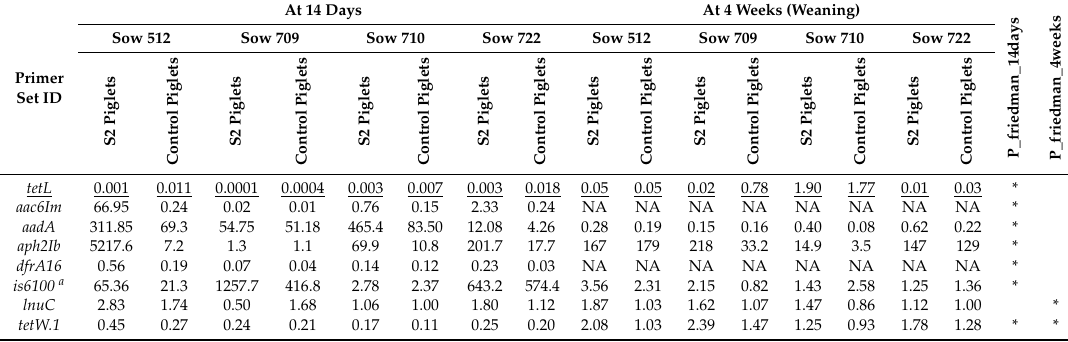
Table 2. Impact of the suspension from donor sow 206 (S2) on the abundance of ARGs and related genes in the piglets at 14 days and at 4 weeks (median values). The ARG abundances are normalized by the abundance of the 16S rRNA gene. The numbers are not between 0 and 1 because the ARGs were pre-amplified, whereas the 16S rRNA genes were not (see Materials and Methods section, Table S4 and Figure S6). The ARG tetL is underlined because it is decreased by the inoculation of the microbial suspension S2 of the